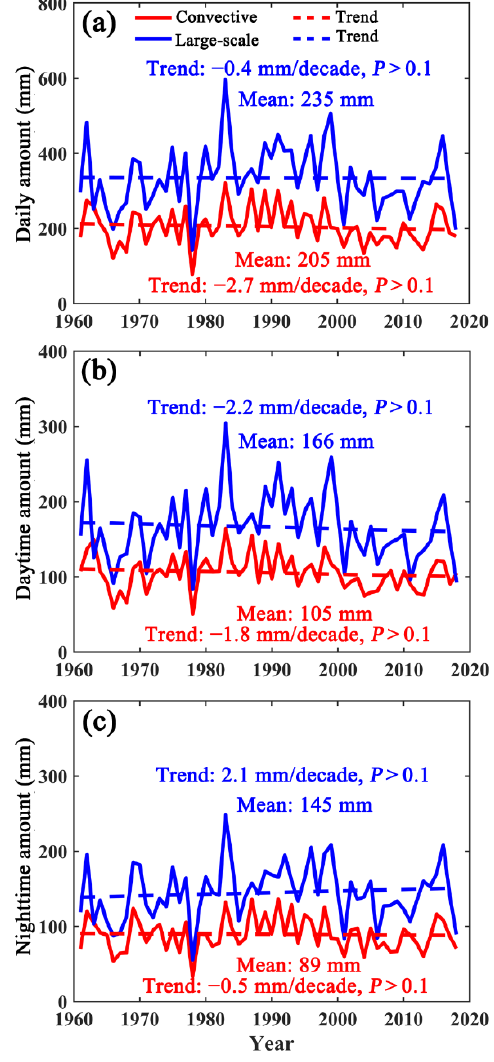
Figure 10. Time series of convective and large-scale precipitation amounts at daily ( a ), daytime ( b ), and nighttime ( c ) scales for the period 1961–2018 in the YRD.